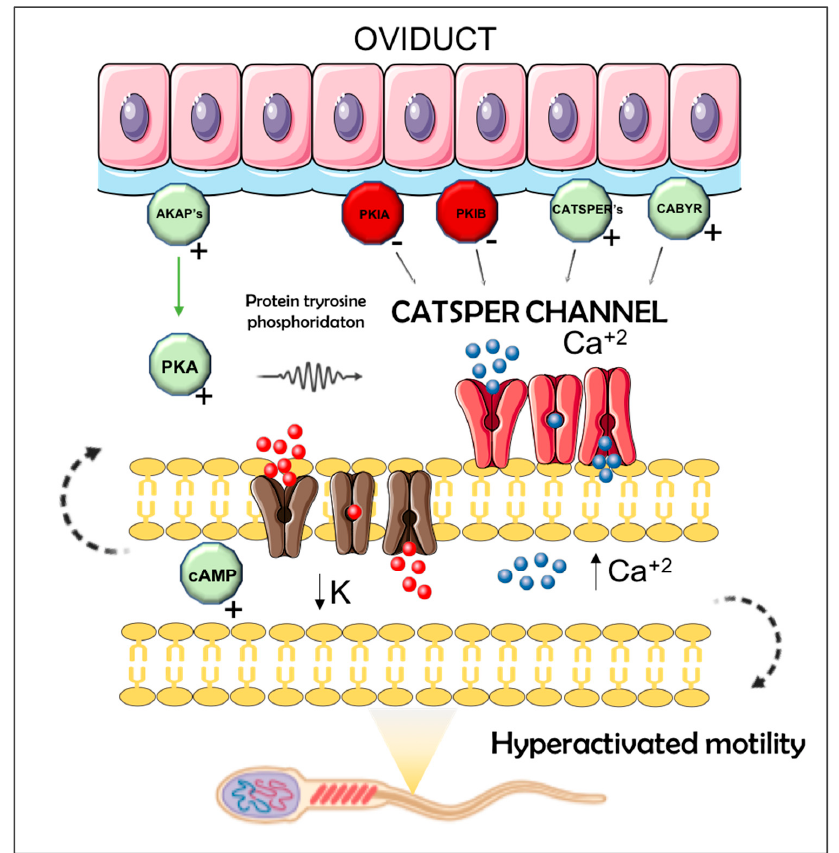
Figure 4. Model for sperm CatSper channel regulation in the oviduct. Possible signal transduction mechanisms of porcine sperm Ca2 + influx through the CatSper channels. The oviductal molecular signaling stimulate the receptors for spermatozoa Ca2 + influx in a positive or a negative manner depending on sperm or seminal plasma exposure. The different factors that are possibly affecting Ca 2+ entry are depicted in the diagram, whereas AKAPs, CATSPERs, and CABYR genes are positive regulator of the Catsper channel, while PKIs and CRISP1 genes are inhibitors of the Catsper channels.